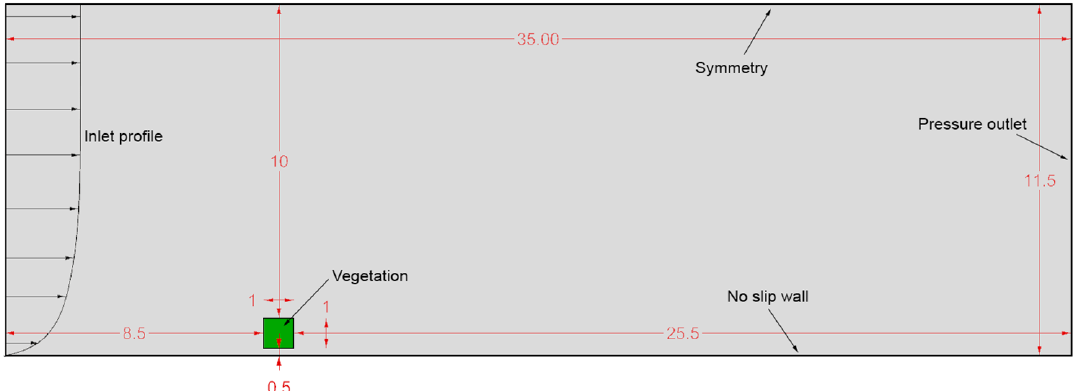
Figure 12. Simulation field of the validation model, based on the porous vegetation according to the indication of the green square and centred on the x -axis. (Reprinted with permission from [29]. Copyright 2019 Mohammadi Murtaza and John Kaiser Calautit.).